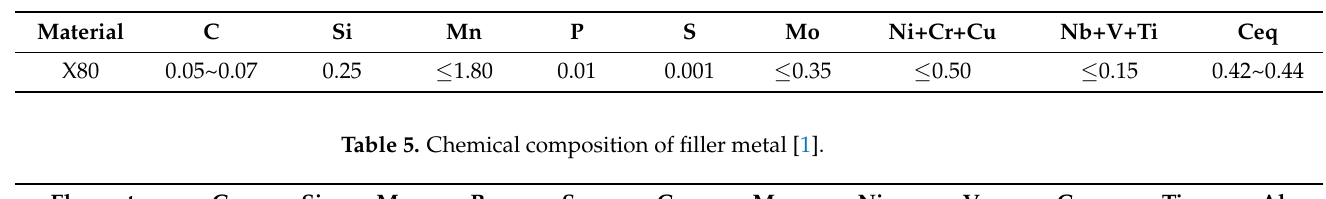
Table 4. Chemical composition of base metal (wt%) [26].